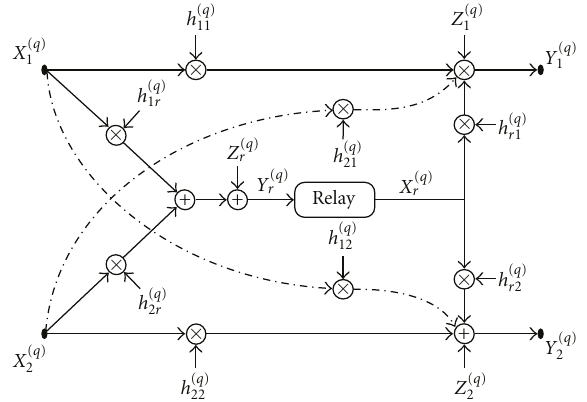
Figure 1: System model: a Q -band interference channel with a relay; q is the band index and q ∈ { 1, ... , Q }